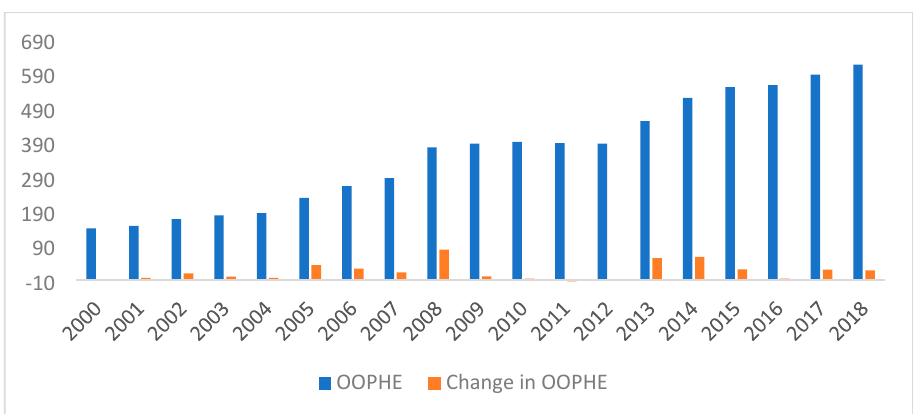
Figure 2. Cumulative change in OOPHE over time.